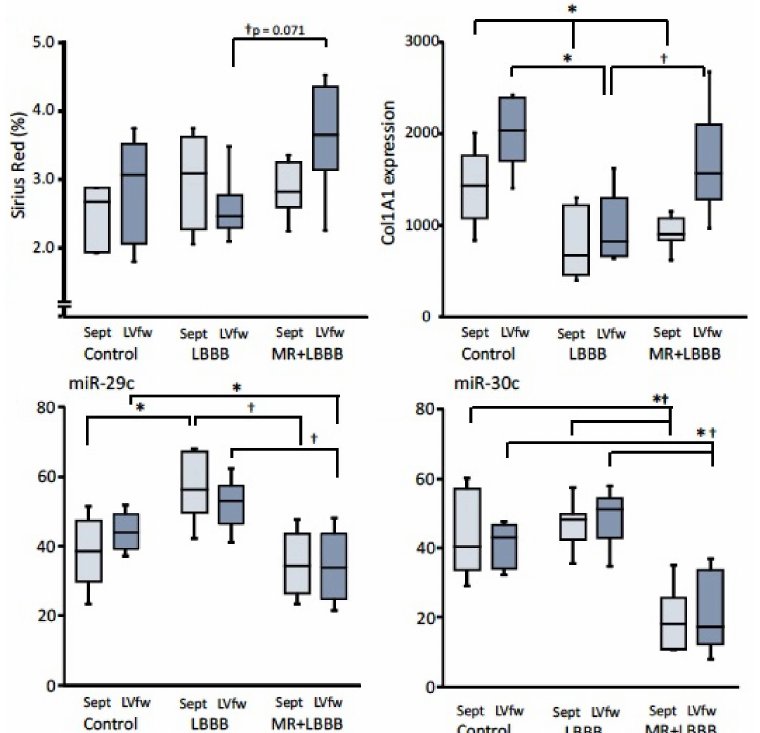
Figure 3. Upper panels: deposition of collagen (Sirius Red staining) and collagen-1A1 expression in control, LBBB and mitral regurgitation + LBBB (MR + LBBB) animals (same as in Figure 2). Lower panels: boxplots of the expression of miRs related to the extracellular matrix (miR-29c and miR-30c). Dark blue boxes represent the left ventricle free wall (LVfw) and light blue boxes represent the septum (Sept). * p < 0.05 vs. control; † p < 0.05 vs. LBBB. Dashed lines indicate 100% (=median of control values in corresponding wall